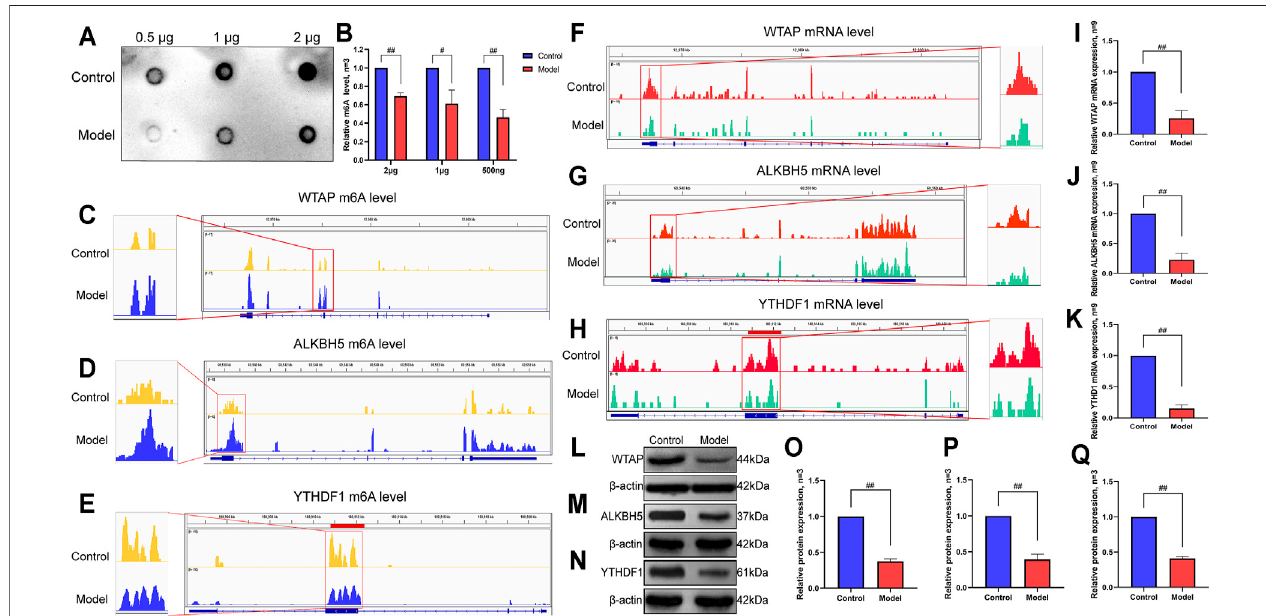
FIGURE 7 | Veri fi cation of m6A methylation level and methylase expression in LF. (A) The m6A methylation level in LF. (B) Semiquantitative analysis of m6A methylation. (C) IGV plots of the WTAP m6A level. (D) IGV plots of the ALKBH5 m6A level. (E) IGV plots of the YTHDF1 m6A level. (F) IGV plots of the WTAP expression level. (G) IGV plots of the ALKBH5 expression level. (H) IGV plots of the YTHDF1 expression level. (I) mRNA expression level of WTAP. (J) mRNA expression level of ALKBH5. (K) mRNA expression level of YTHDF1. (L) Protein expression levels of WTAP. (M) Protein expression levels ofALKBH5. (N) Protein expression levels